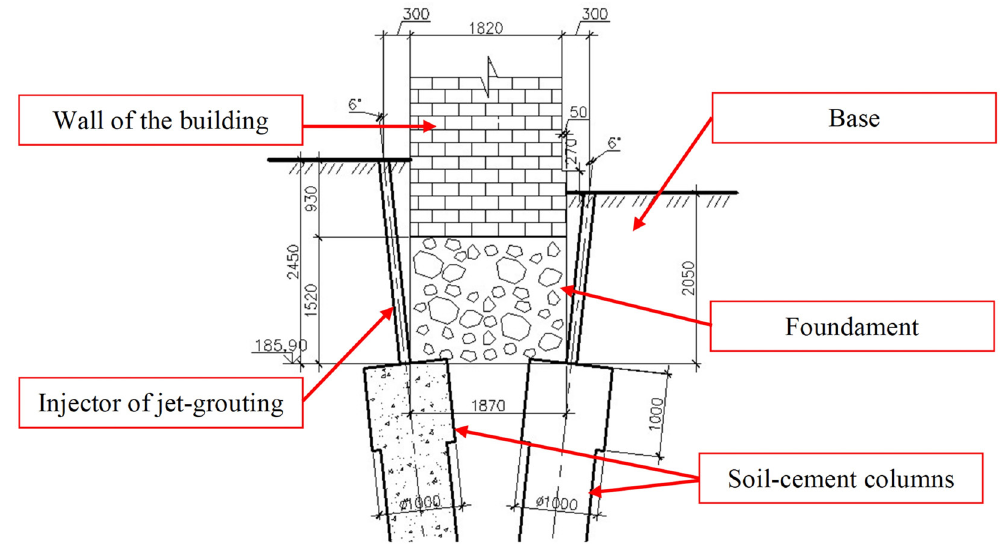
Figure 8. Design of soil strengthening under the foundation (a fragment).